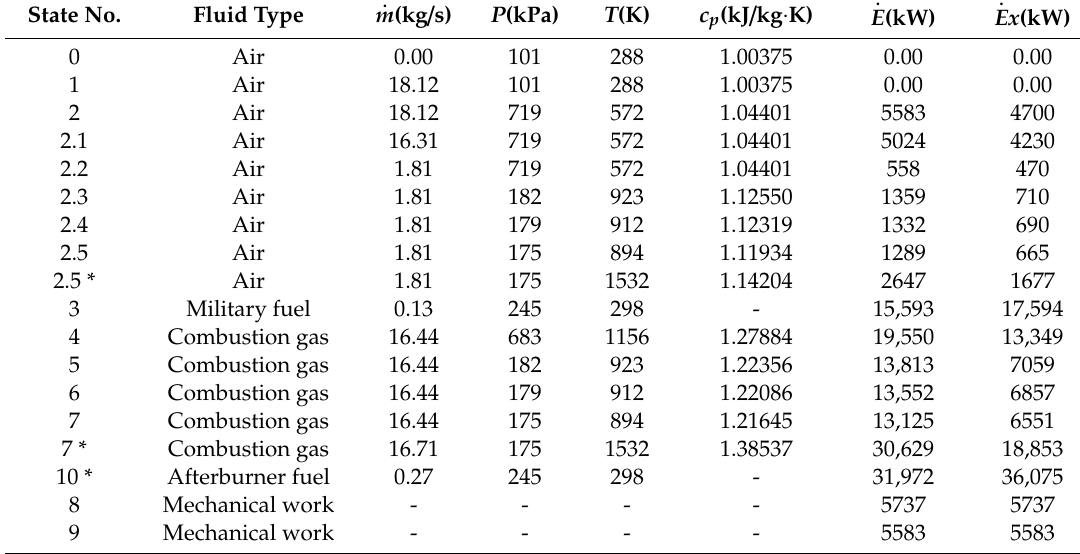
Table A2. Values for energy rate, exergy rate, mass flowrate, pressure and specific heat capacity for the system sections for H 2 fuel utilization (*: solely for AB process mode) [63]. State No.